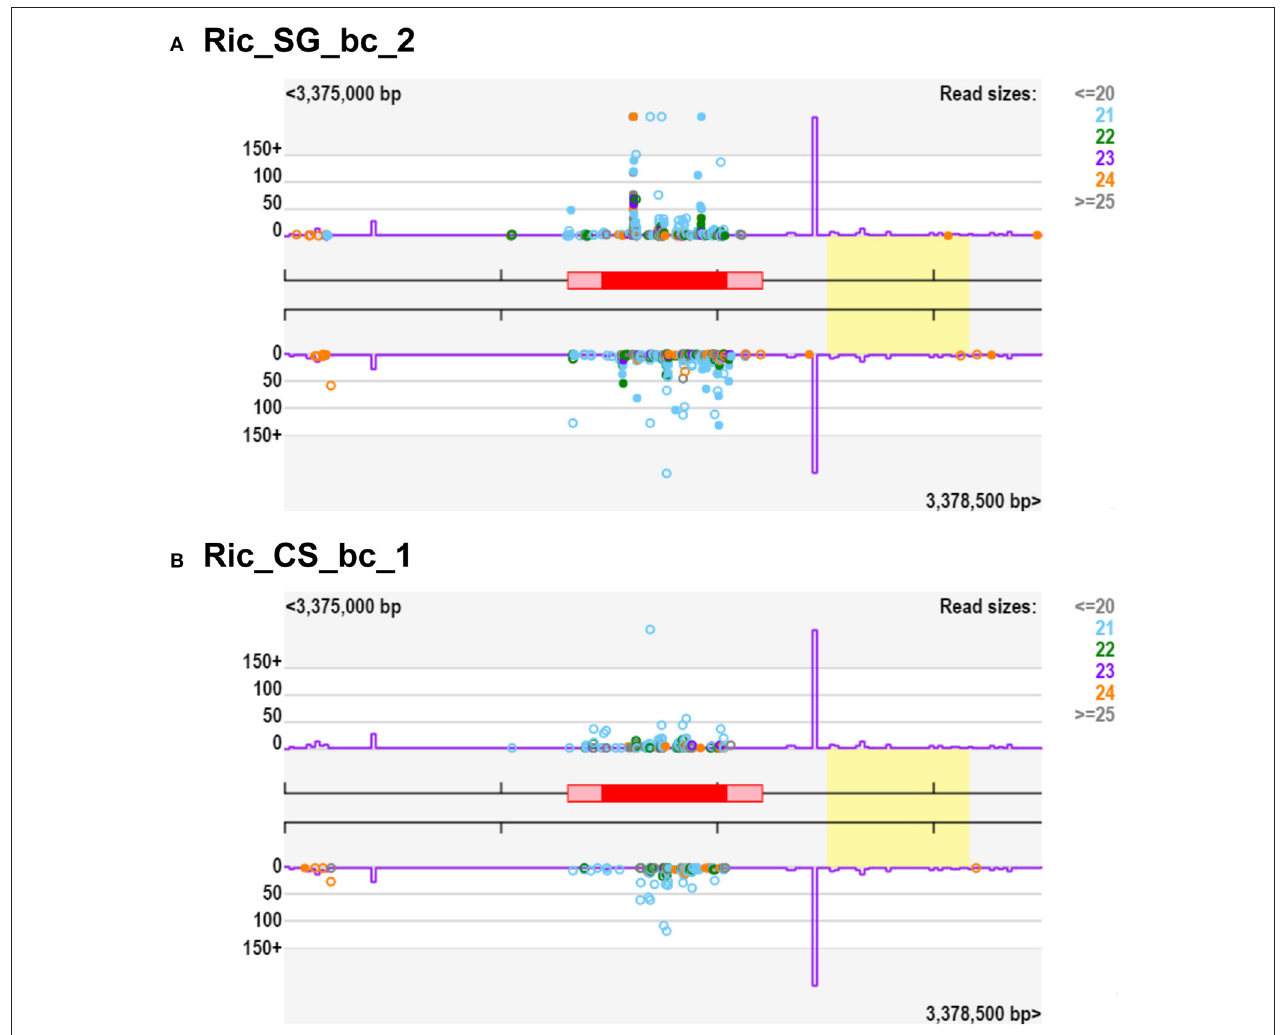
FIGURE 6 | Small RNA-producing loci of Vitis vinifera berries with 390-fold change considering SG/CS. The gene in this locus (red box) codes for a protein annotated as “BURP domain-containing protein 3-like,” located on chromosome 4 (VIT_204s0008g04040). (A) Representation of small RNAs from Ric_SG_bc_2 mapping to this locus, (B) Representation of small RNAs from Ric_CS_bc_1 mapping to this locus. Violet line is the “k-mer” frequency and the yellow box indicate homology to a transposable element. Ric, Riccione; CS, Cabernet Sauvignon; SG, Sangiovese; bc, green, bunch closure developmental